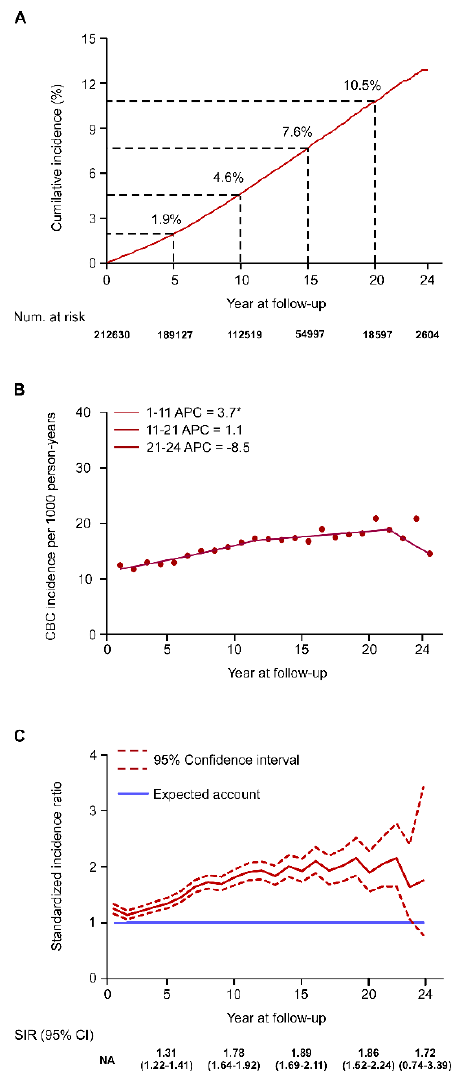
Figure 1. Temporal trend in contralateral breast cancer (CBC) incidence over the 24-year follow-up period (1990–2013). ( A ) Cumulative incidence of CBC in early-stage breast cancer (BC). ( B ) Trend of CBC incidence per 1000 person-years estimated by joinpoint regression (Trend 1: years 1–11, Trend 2: years 11–21, Trend 3: years 21–24). ( C ) Trend in standardized incidence ratio (SIR) CBC in early-stage BC compared with the general population. * P < 0.05. NA = not available.